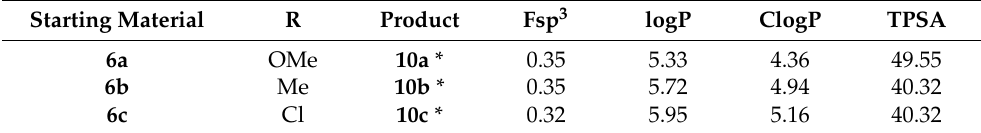
Table 3. The physicochemical parameters of the triazole derivatives ( 10a–c ).